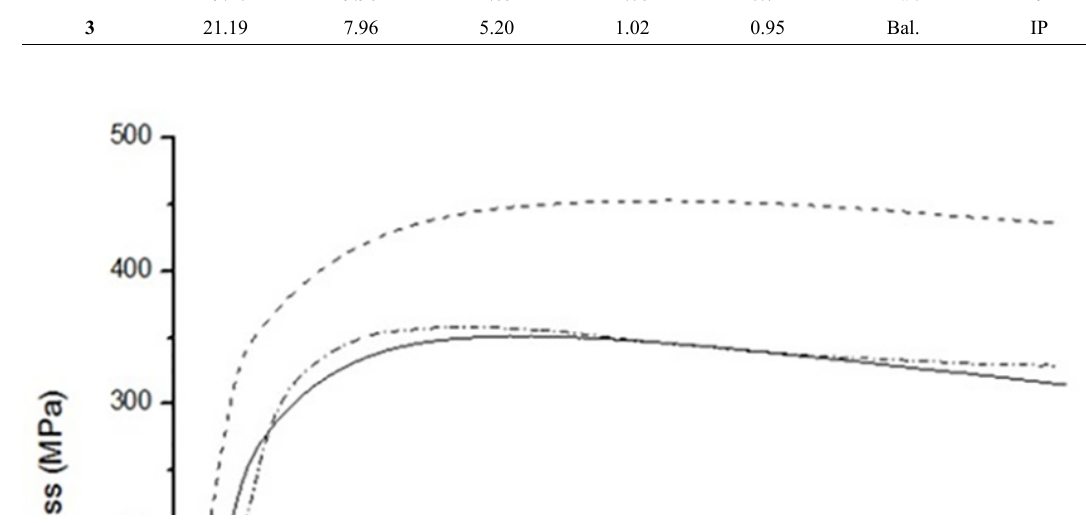
Figure 5. Phase maps obtained by EBSD in un-aged weld metals: (a) GTAW. (b) FSW Table 9. Amounts of phases determined by EBSD in the weld metal GTAW.